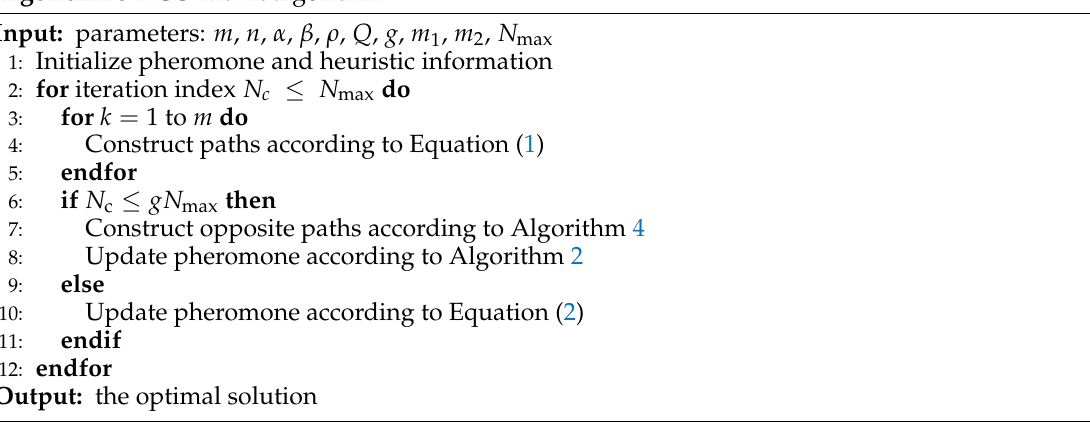
Algorithm 5 ACO-MaxIt algorithm